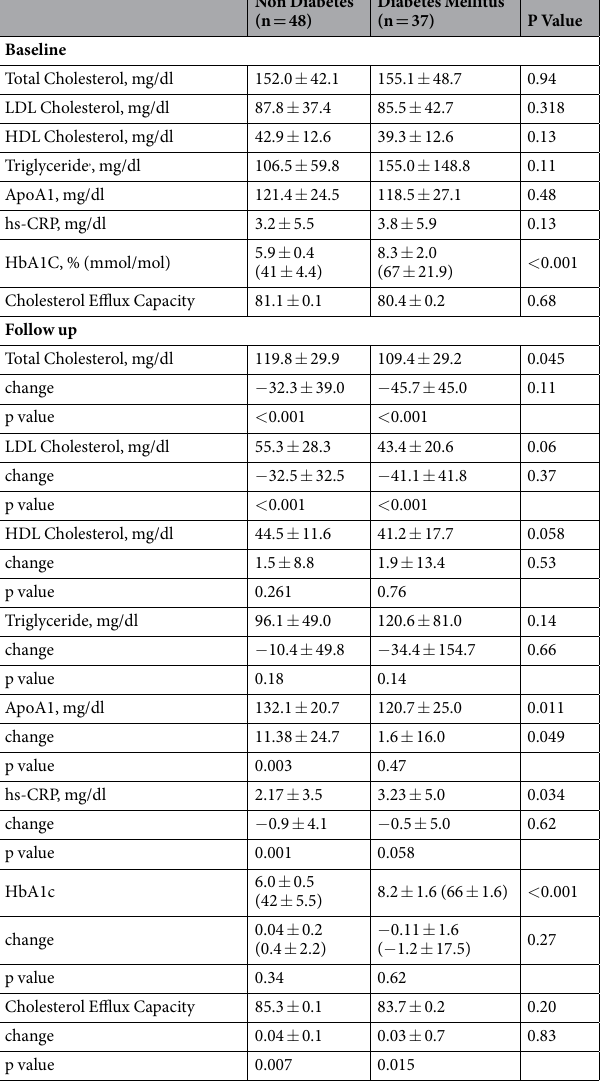
genes (Fig. 1: Schematic of transcriptomic analysis workflow). In the DM group, we did not detect any genes differentially expressed from baseline to follow-up at an FDR-corrected P value of less than 0.05 (Supplementary Figure 1: Differential expression heatmap). In the non-DM group, we detected two genes differentially expressed from baseline to follow-up ( FOLR3 and C15orf54 ). FOLR3 , or folate receptor three (gamma), is a ubiquitously expressed folate receptor that was downregulated following statin exposure. In a previous study, FOLR3 was upregulated in patients with early onset coronary artery disease compared to matched controls 16 . C15orf54 is a poorly studied open reading frame on chromosome 15. This locus has previously been found to contain two single nucleotide polymorphisms (SNPs), both associated with cardiovascular phenotypes. The first, rs12907914, was found to be associated with increased risk for heart failure-related, left ventricle hypertrophy in an African American cohort 17 . In an independent study, rs17691453 was found to be associated with the small molecule metabolite dihydroxy docosatrienoic acid, which has been identified as a risk factor for heart failure 18 . Controlling for study time point, we did not detect any genes differentially expressed between DM and non-DM patients. Weighted Gene Coexpression Network Analysis. Two of the 19 modules of genes discovered via WGCN analysis were statistically associated with diabetes status (p < 0.10). Significantly associated modules were named for their most significant cardiovascular-associated GO Biological Processes. The first gene expression module (Collagen Module) contained 40 coexpressed genes and the second module (Platelet Module) contained 242 genes (Fig. 2A: WGCNA module clustering. Correlation networks within Collagen Module (2B) and Platelet Module (2 C). In our previous work, we showed the collagen gene module to be associated with fibrous cap